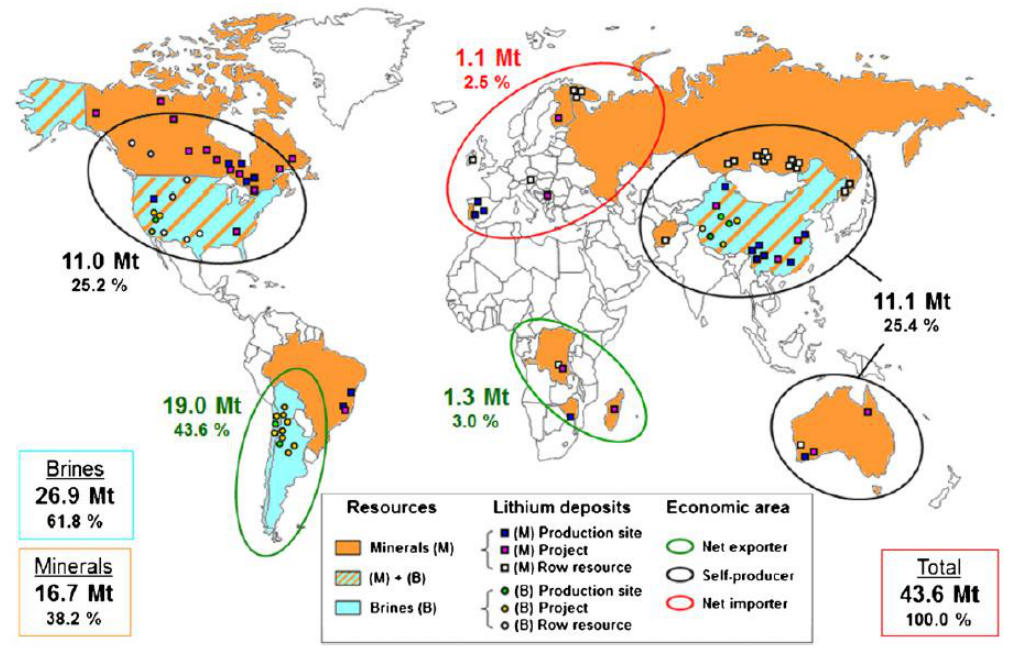
Figure 6. Projected lithium resources by source type (brine vs. hard rock) [2]. It is expected that lithium production will develop globally in response to lithium demand [2,22]. Reprinted from Renewable and Sustainable Energy Reviews, v. 16(3), Grosjean et al., Assessment of world lithium resources and consequences of their geographic distribution on the expected development of the electric vehicle industry, 1735–1744., Copyright 2012, with permission from Elsevier.